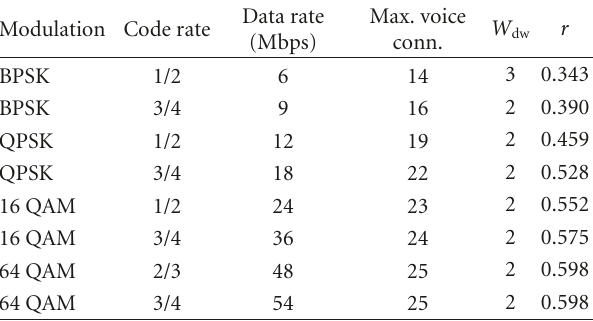
Table 2: The maximum numbers of supported voice connections under di ff erent 802.11a PHY-layer